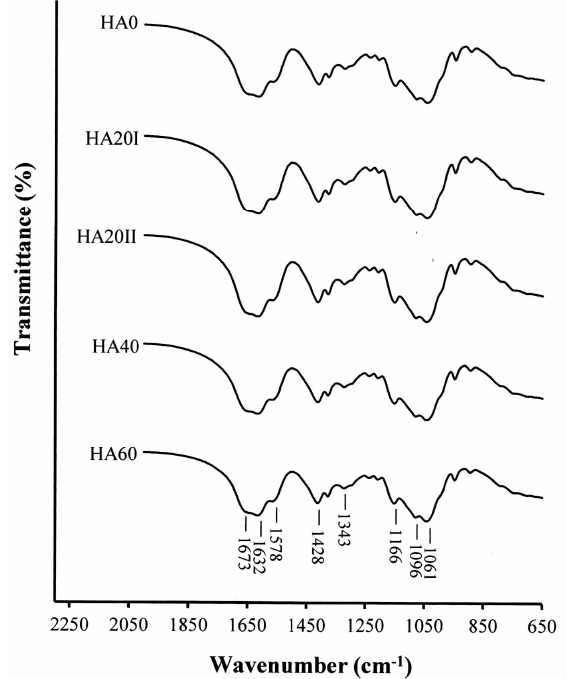
Figure 3. FTIR spectra of high-molecular-weight hyaluronic acid (HMWHA) and low-molecular-weight hyaluronic acid (LMWHA) treated with various doses of γ -ray irradiation.